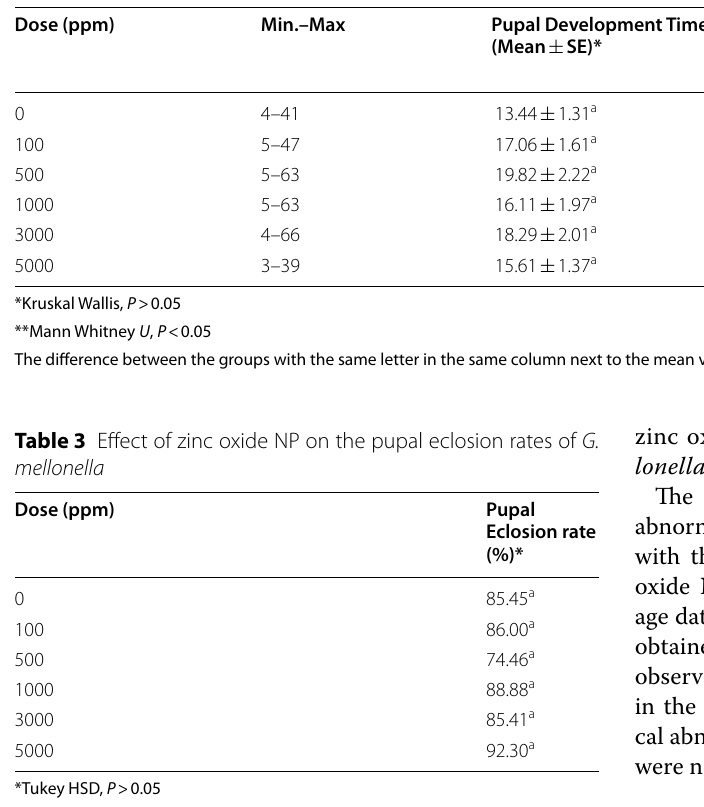
Table 2 The effect of zinc oxide NP on G. mellonella ’s pupal development time and pupal weight